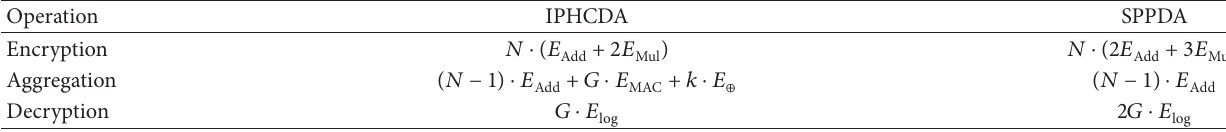
Table 7: The computation overhead of IPHCDA and